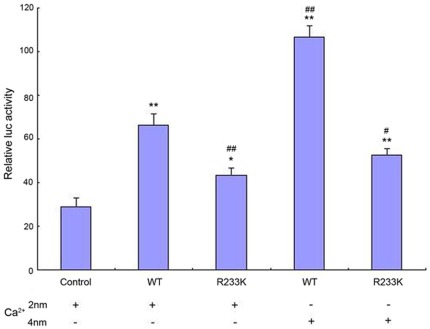
The binding affinity of R233K-AQP0 to CaM.R233K mutant decreased the binding affinity of AQP0 to CaM and was insensitive to calcium regulation. HEK 293t cells were contransfected with the TK promoter reporter plasmid, the Renilla luciferase internal control plasmid, the VP16-CaM plasmid and the indicated constructs (including Gal4-MIP-wt, Gal4-MIP-R233K, as well as empty vector pCMX-Gal4). To assess the binding affinity of R233K-AQP0 to CaM, relative luciferase activity was measured after transfected for 30 hours in the presence of different calcium concentration (2 mM or 4 mM CaCl2). Data were shown as mean values from four independent experiments. Significant differences were calculated using the independent-sample t test. *p<0.05, ** p<0.01 compared with empty vector pCMX-Gal4; # p<0.05, ## p<0.01 compared with Gal4-MIP-WT. Significant differences were found between wt and R233K.